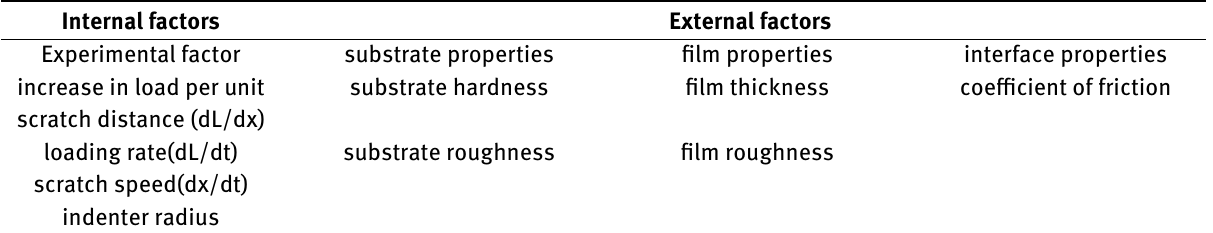
Table 3: Main influencing factors of critical load Internal factors External factors Experimental factor substrate